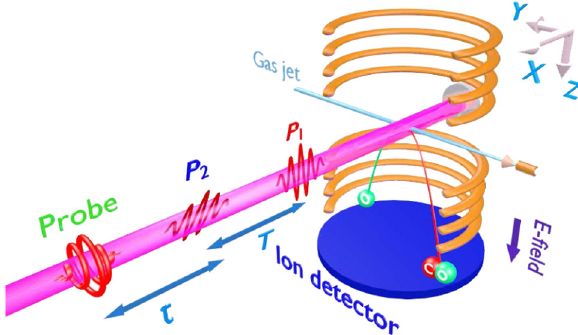
FIG. 1. Experimental setup. A supersonic gas jet of CO 2 molecules subject to a pair of polarization-skewed and time- delayed femtosecond laser pulses in an ultrahigh vacuum chamber of COLTRIMS is used to create molecular alignment echoes. By scanning the delay of an intense circularly polarized probe pulse, snapshots of the angular distribution of the molecu- lar axis at various times are taken via Coulomb